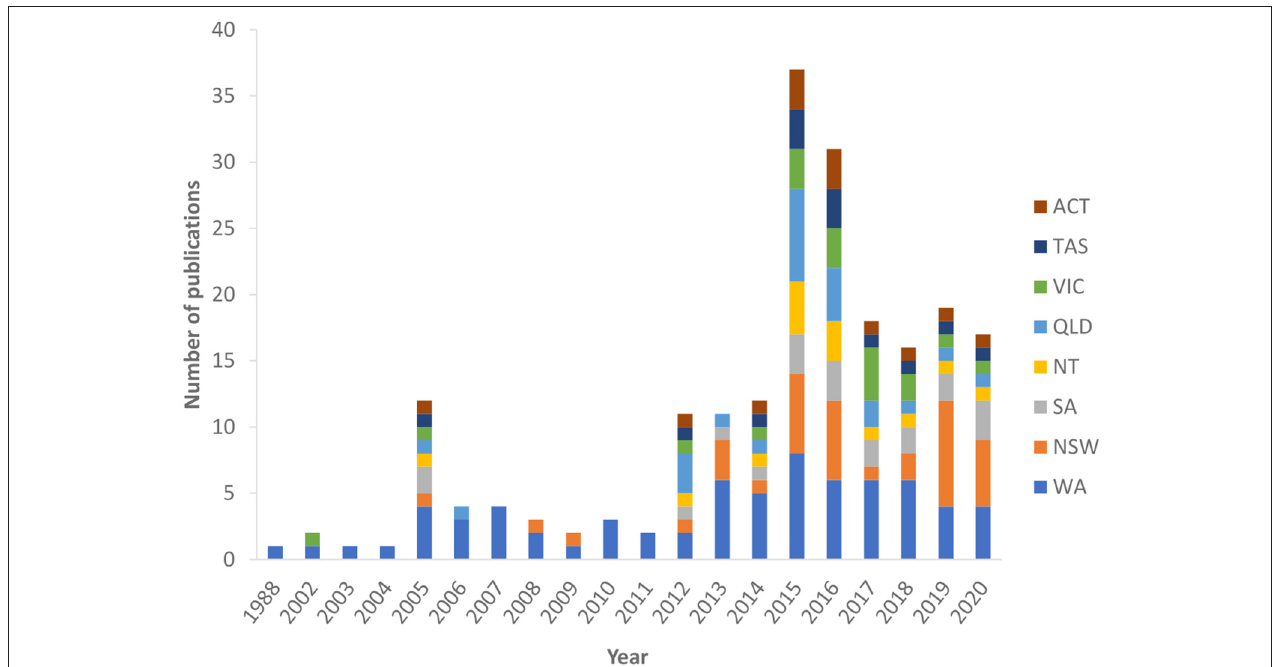
FIGURE 2 | Number of data linkage publications on diabetes by state and publication year. WA, Western Australia; NSW, New South Wales; SA, South Australia; NT, Northern Territory; QLD, Queensland; VIC, Victoria; TAS, Tasmania; ACT, Australian Capital Territory. Studies involving linked data from multiple states were counted as one publication for each